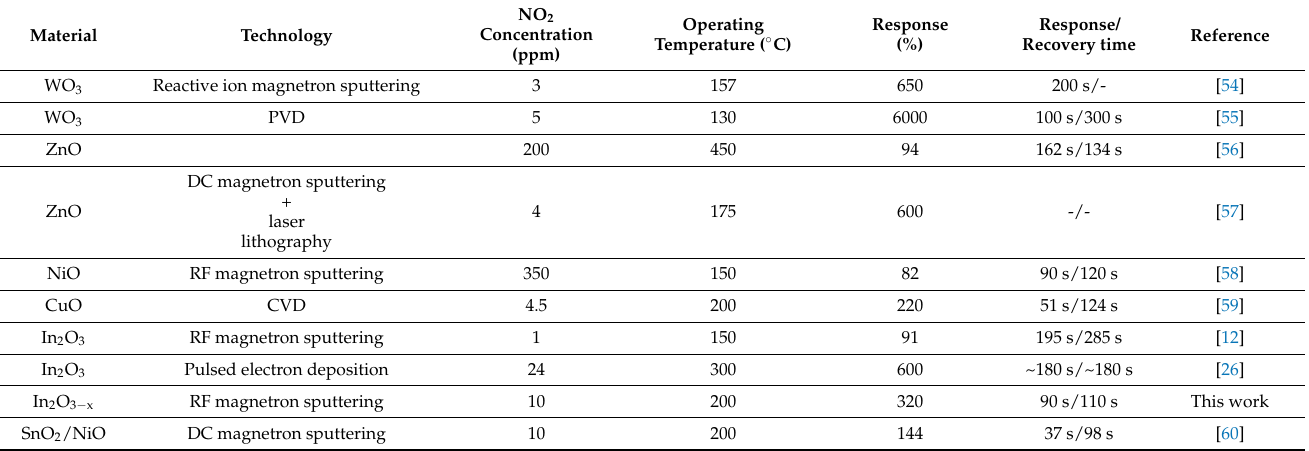
Table 2. Sensing performance of MOX-based thin film